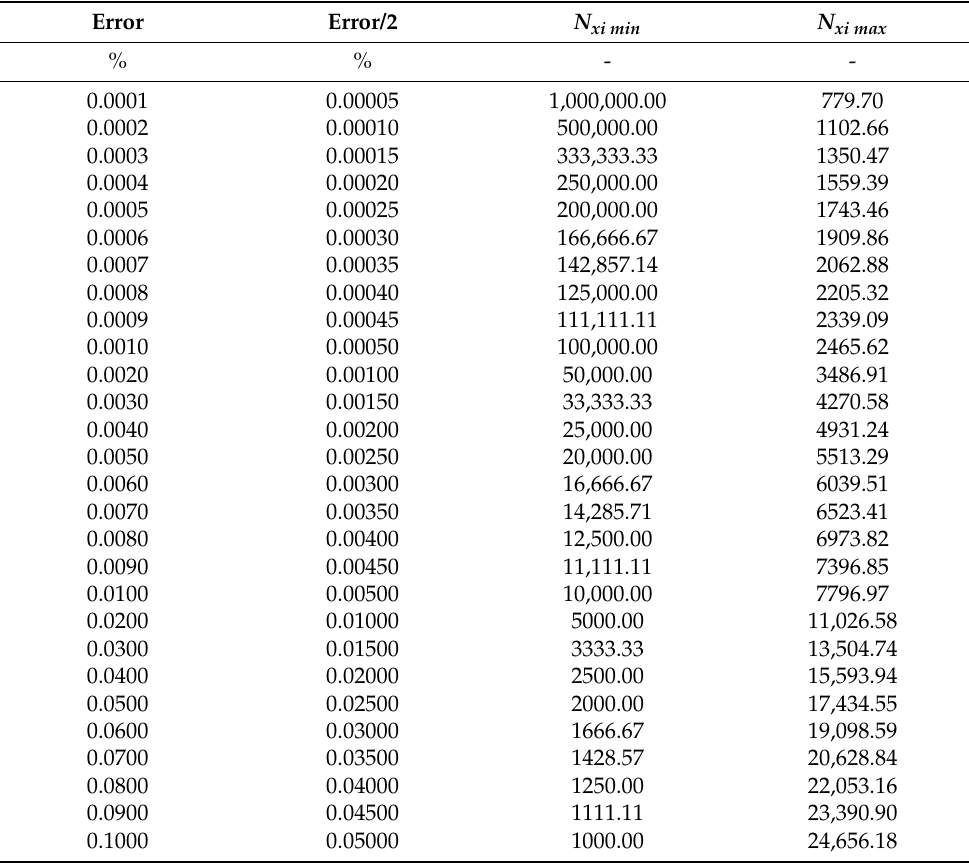
Table 1. Calculation results of the threshold values of N xi